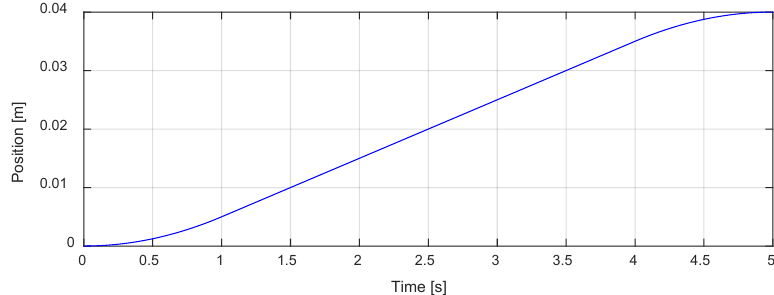
Figure 3. X-axis and Y-axis reference position profiles. The estimation performances of the proposed NOB for the X-axis position, yaw rota- tion, and phase currents are shown in Figures 4–6, respectively. Because the proposed NOB was designed to estimate state variables, all of the estimation errors for the X-axis, yaw, and currents converged to zero in a steady-state region. However, transient errors still arose in an acceleration velocity region before 1 s.